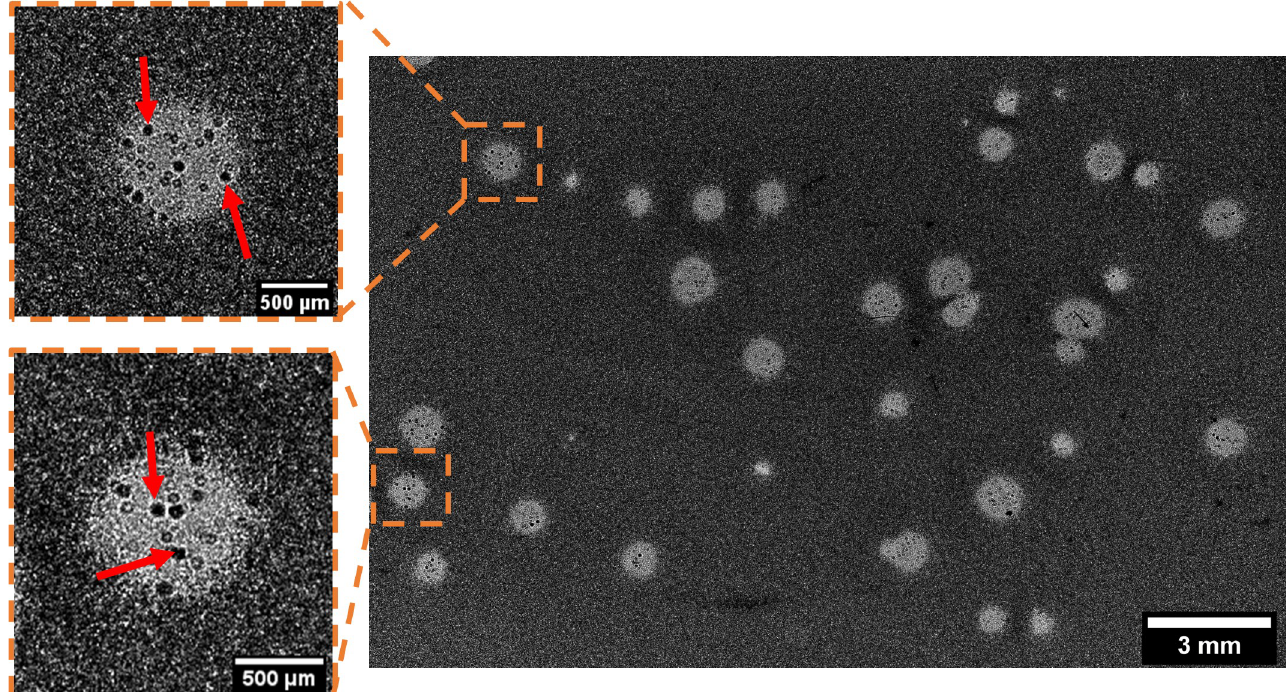
Fig 8. Lensless imaging of K . pneumoniae bacterial microcolonies developing within plaques after 23 hr of incubation. The red arrows indicate microcolonies within plaques.